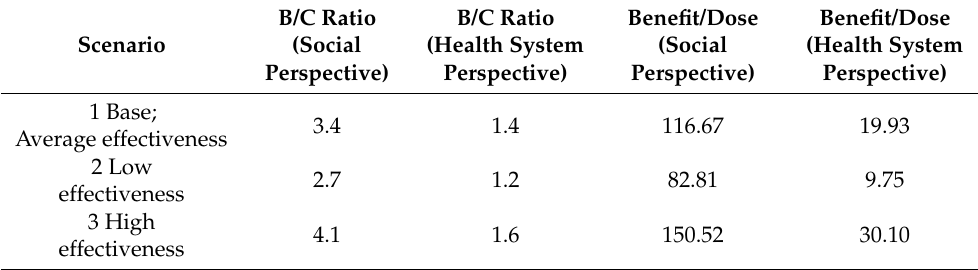
Table 4. Benefit-cost and benefit-dose ratios of the vaccination